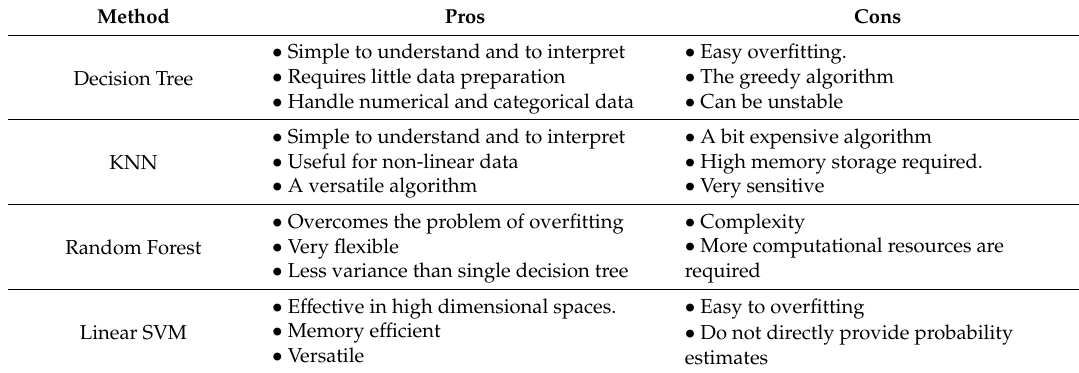
Table 5. The pros and cons of classification